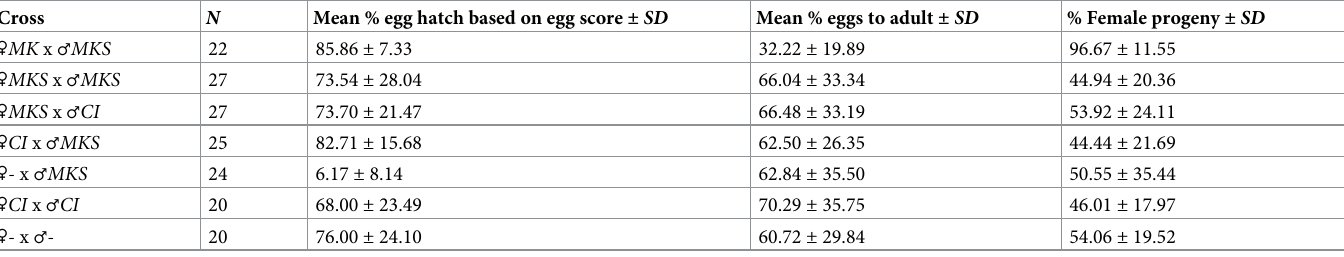
N is the number of replicates after those that did not mate and those that had < 7 eggs were